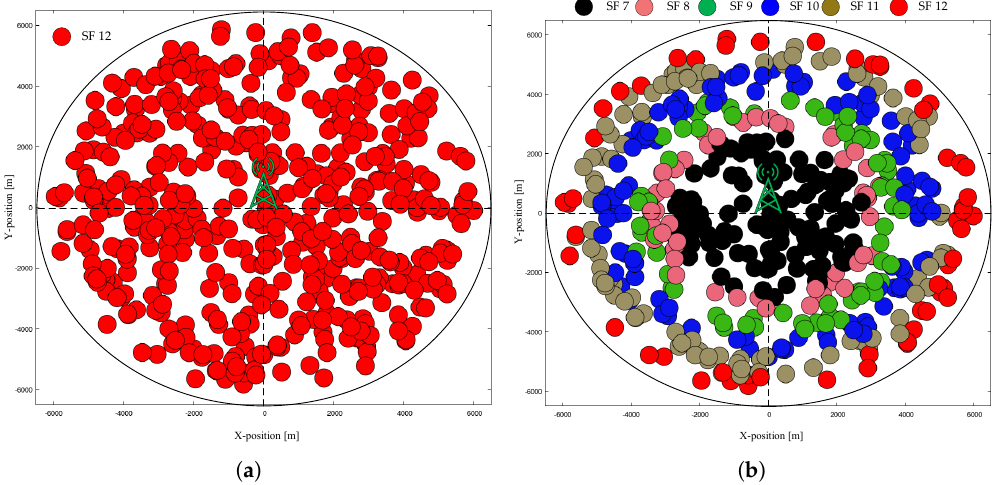
Figure 6. Initial network topology in the case of static EDs with N = 500: ( a ) starting SF = 12, and ( b ) starting SF = I-SFA.